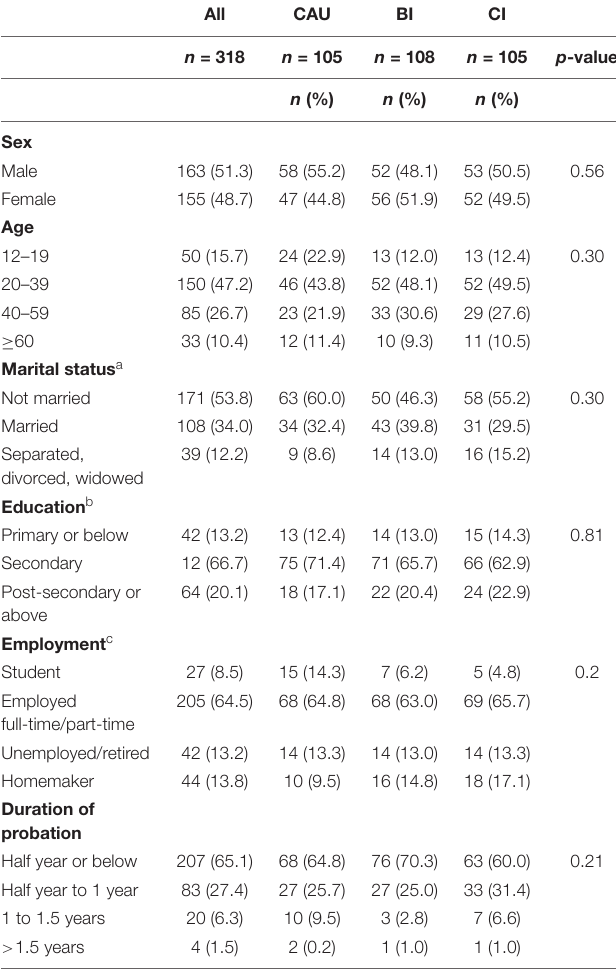
TABLE 2 | Baseline demographic characteristics of probationers ( n =